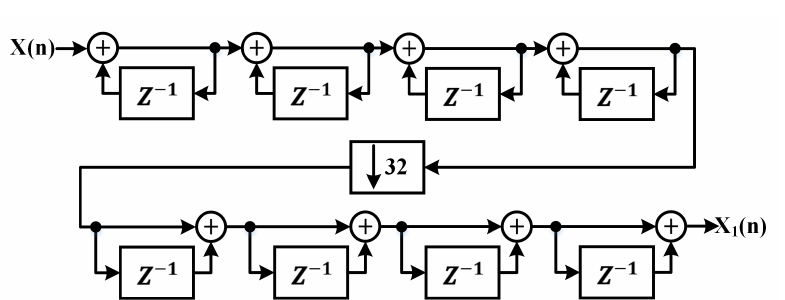
Figure 4. Structure of the CIC decimation